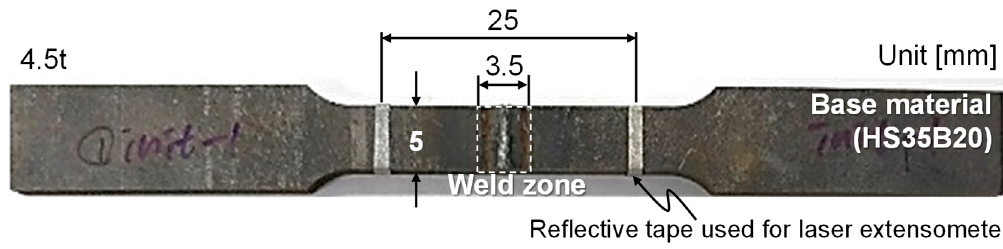
Figure 2. Tensile specimen (ASTM E8M-11).